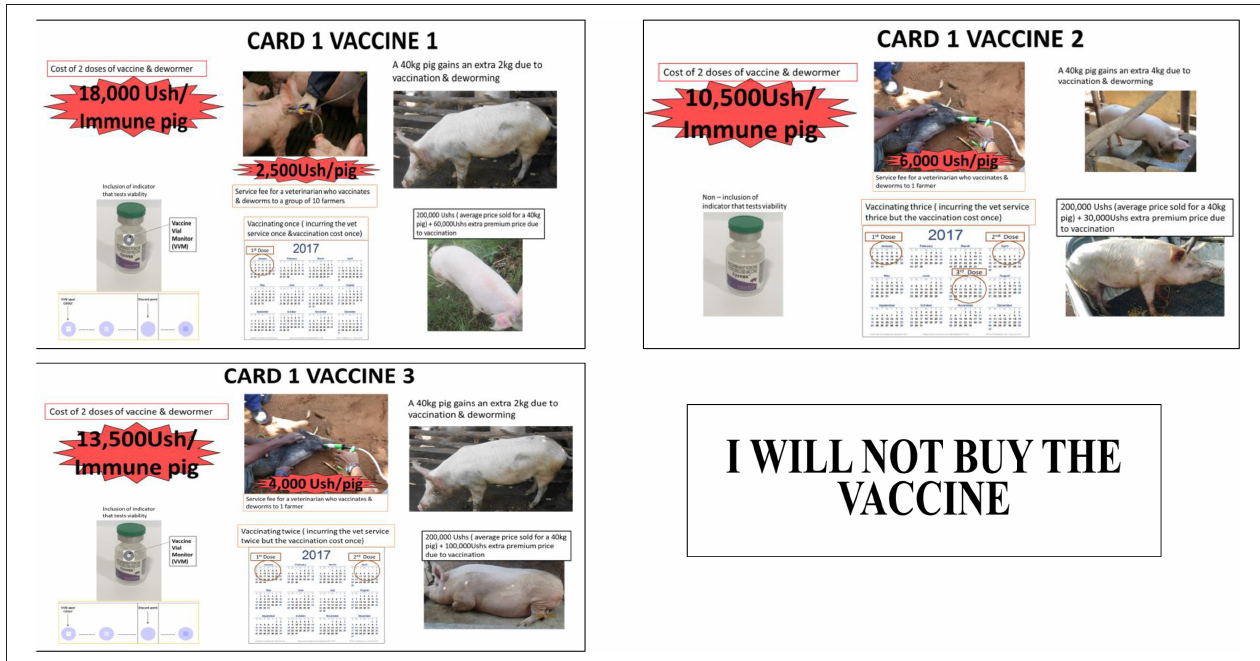
FIGURE 1 | An example of a choice set option for farmers.